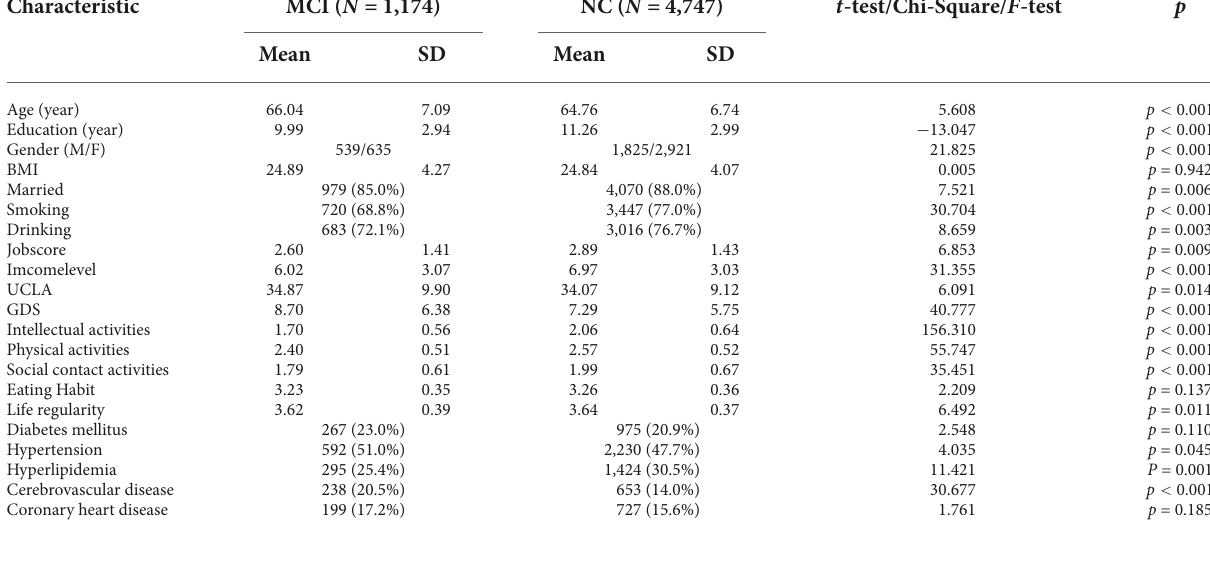
TABLE 1 Characteristics of the study sample at